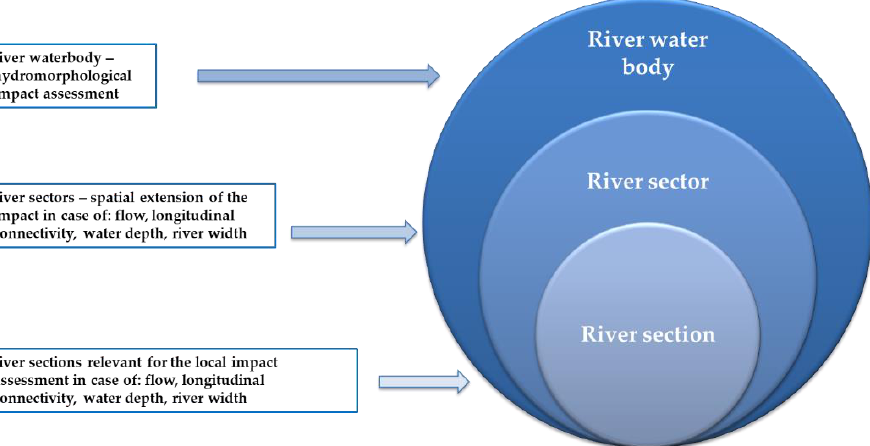
Figure 4. The levels of hydromorphological cumulative impact assessment — schematic representa- tion.